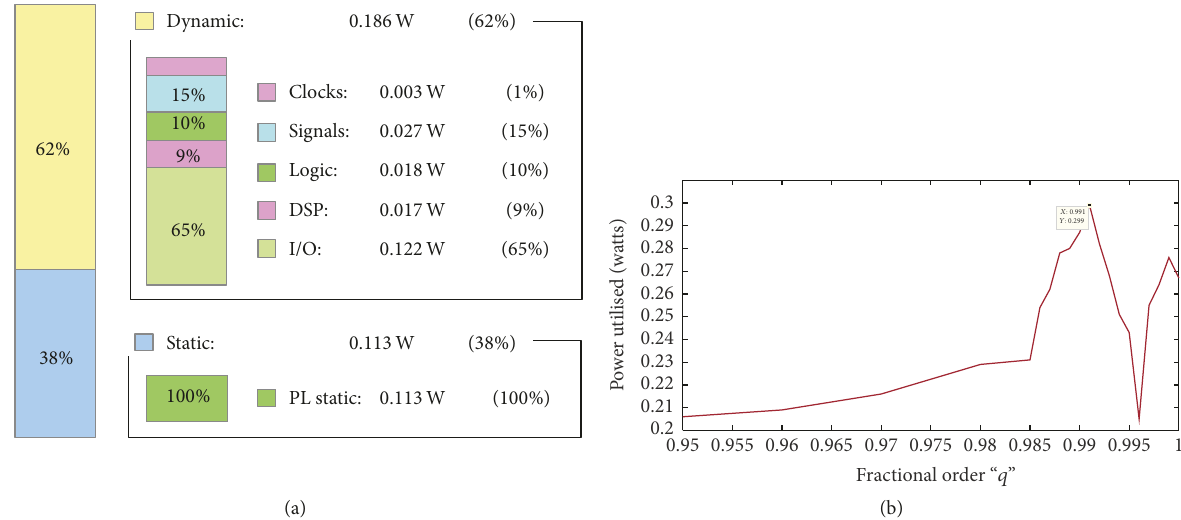
Figure 18: (a) Power utilized and (b) power utilization versus fractional order of FONCS-1 system.